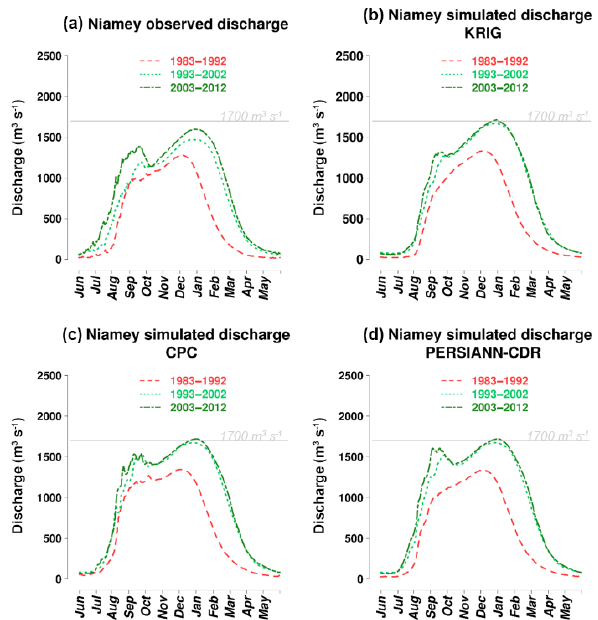
Figure 6. Observed and simulated decadal mean Niamey discharge between 1983 and